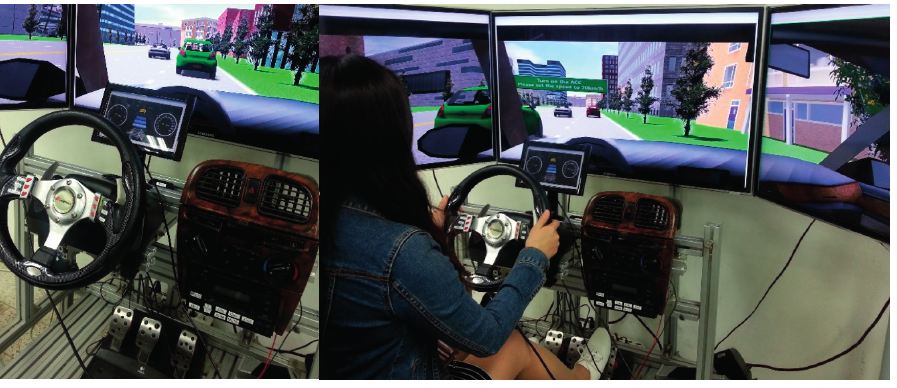
Figure 8. Participant operating the simulator during the